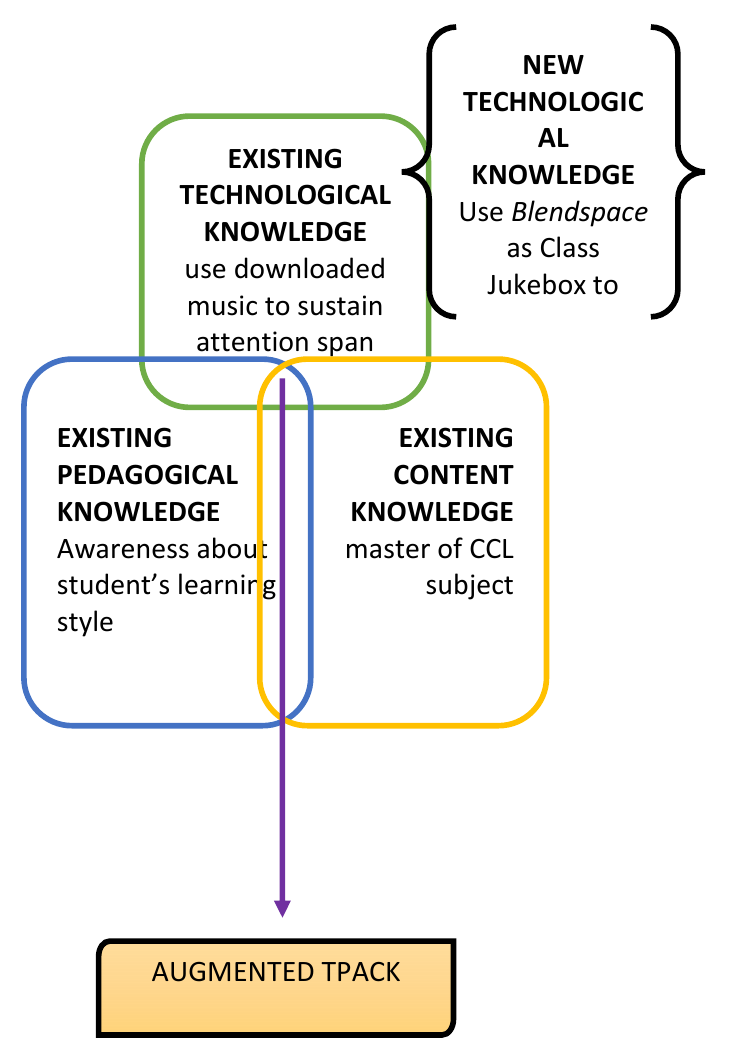
Figure 5: Sample of conceptual augmented TPACK